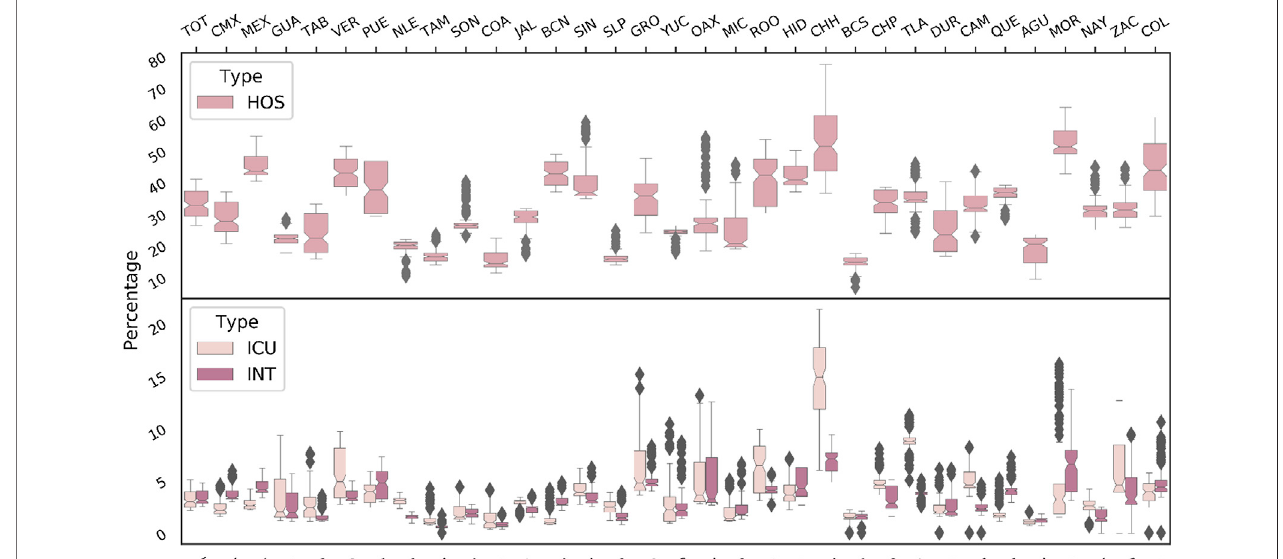
FIGURE3 | National requirementsofIntensiveCare Units beds (ICU), intubation facilities(INT) and hospital beds (HOS).Thesepercents arebased on thereported dataofinfectedcasesthatrequireICU,INTorHOS.Boxplotsarecomposedbydatasetsfrom12apriltill15August.Therefore,thosestateswithsmallboxplotsreveala very stable needs in public health capacities in time (e.g., CMX). Data was extracted from Ref. [26].